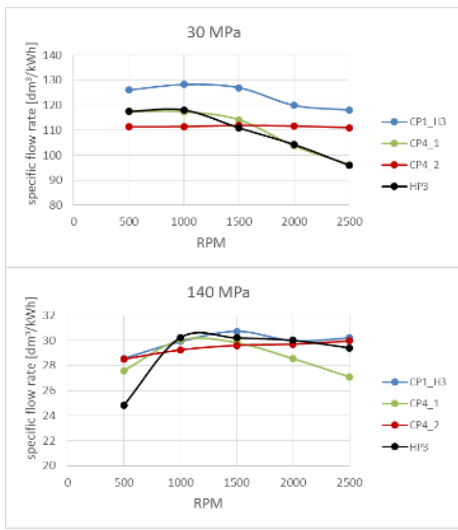
Fig. 2. Comparison of pump specific flow rates as a function of pump shaft speed for pumping pressures of 30 and 140 MPa